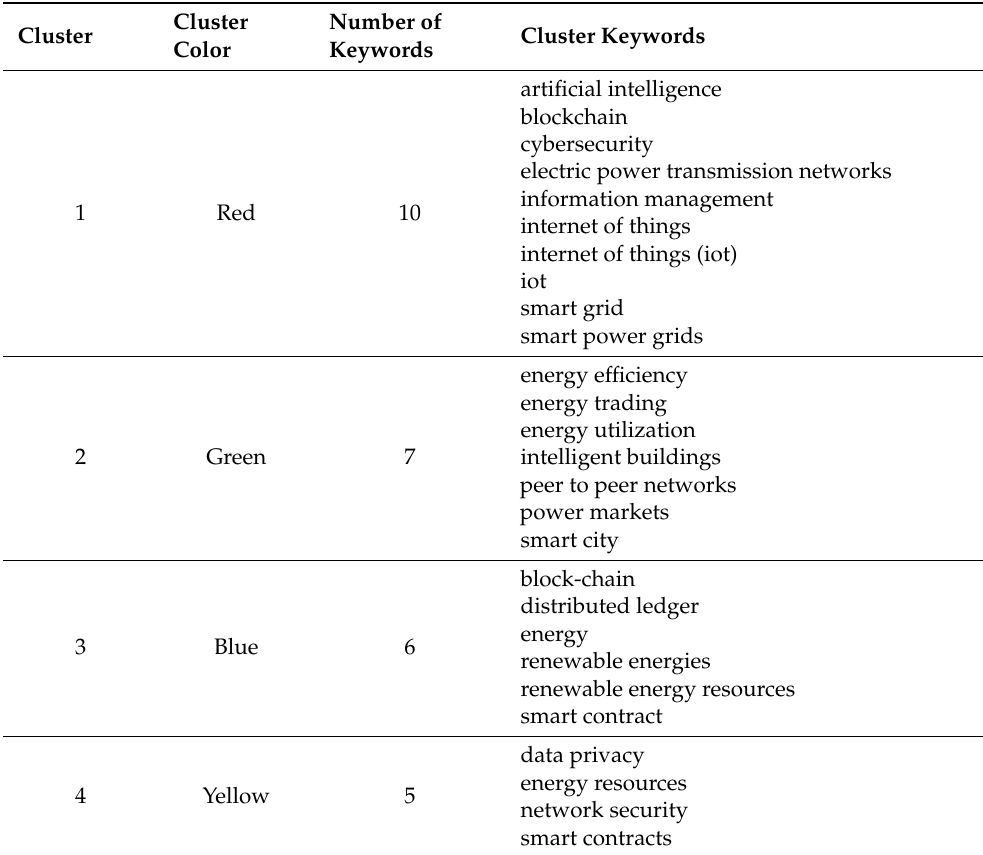
Table 1. Clusters from bibliometric